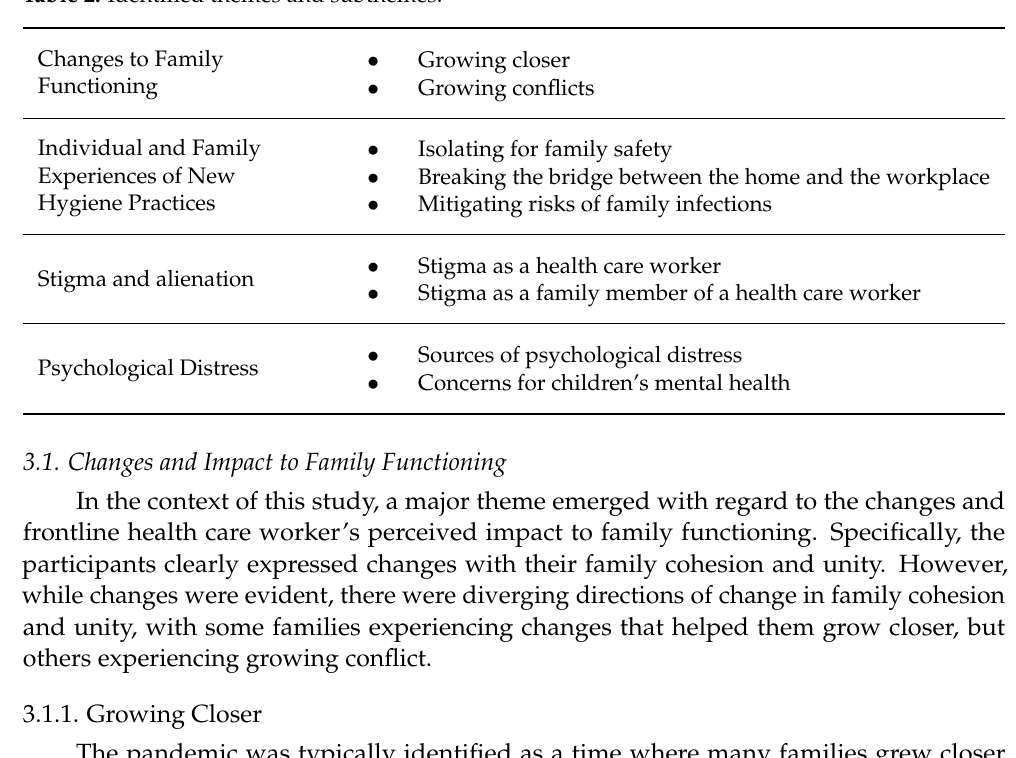
Table 2. Identified themes and